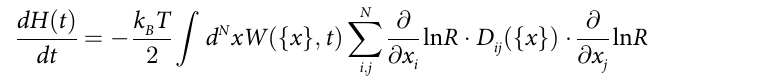
PLOS ONE | https://doi.org/10.1371/journal.pone.0230076 March 11,